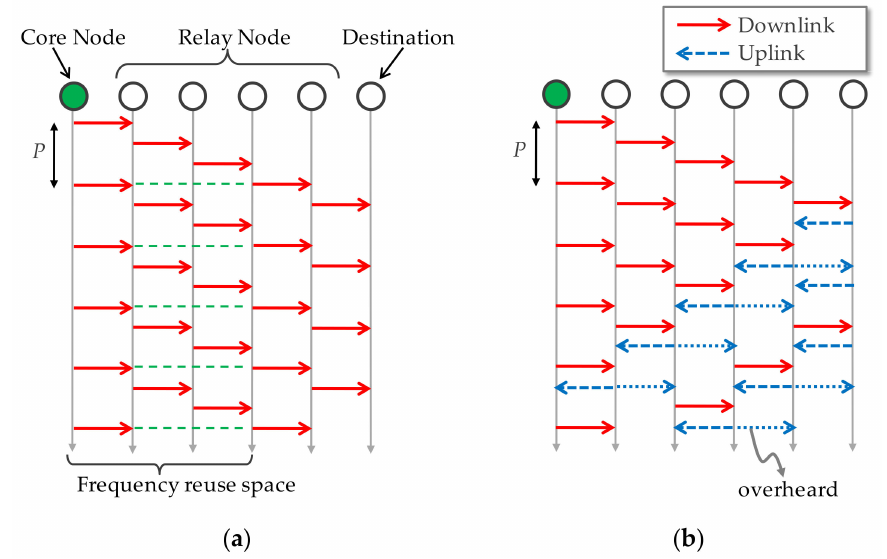
Figure 2. Intermittent Periodic Transmit (IPT). ( a ) Uni-directional IPT; ( b ) Bi-directional IPT.